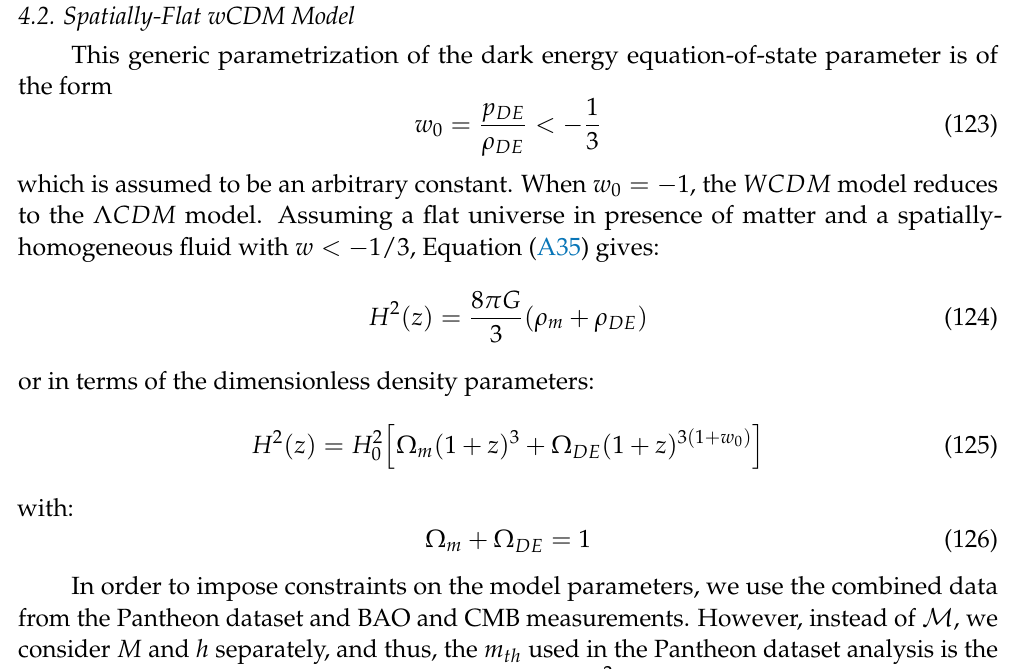
Figure 16. The 1 σ − 3 σ confidence contours in the parametric space ( M− Ω 0 m ) .The red contour corre- sponds to the full Pantheon dataset while the blue contour corresponds to the Pantheon+CMB+BAO data combination. As expected, when the CMB+BAO data are included the constraints on Ω 0 m improve